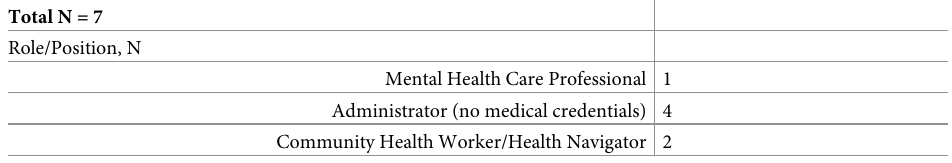
Table 3. Roles of health care professionals who participated in a focus group discussion (1 focus group discussion).